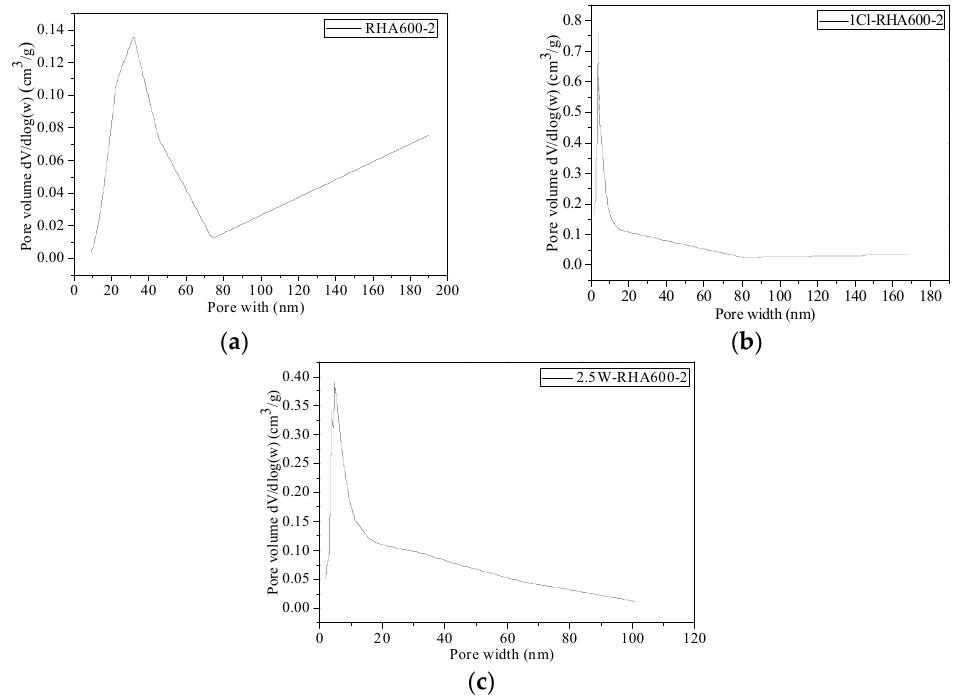
Figure 2. Pore size distribution calculated via BJH algorithm of ( a ) untreated RHA; ( b ) acid-treated RHA and ( c ) water-treated RHA.